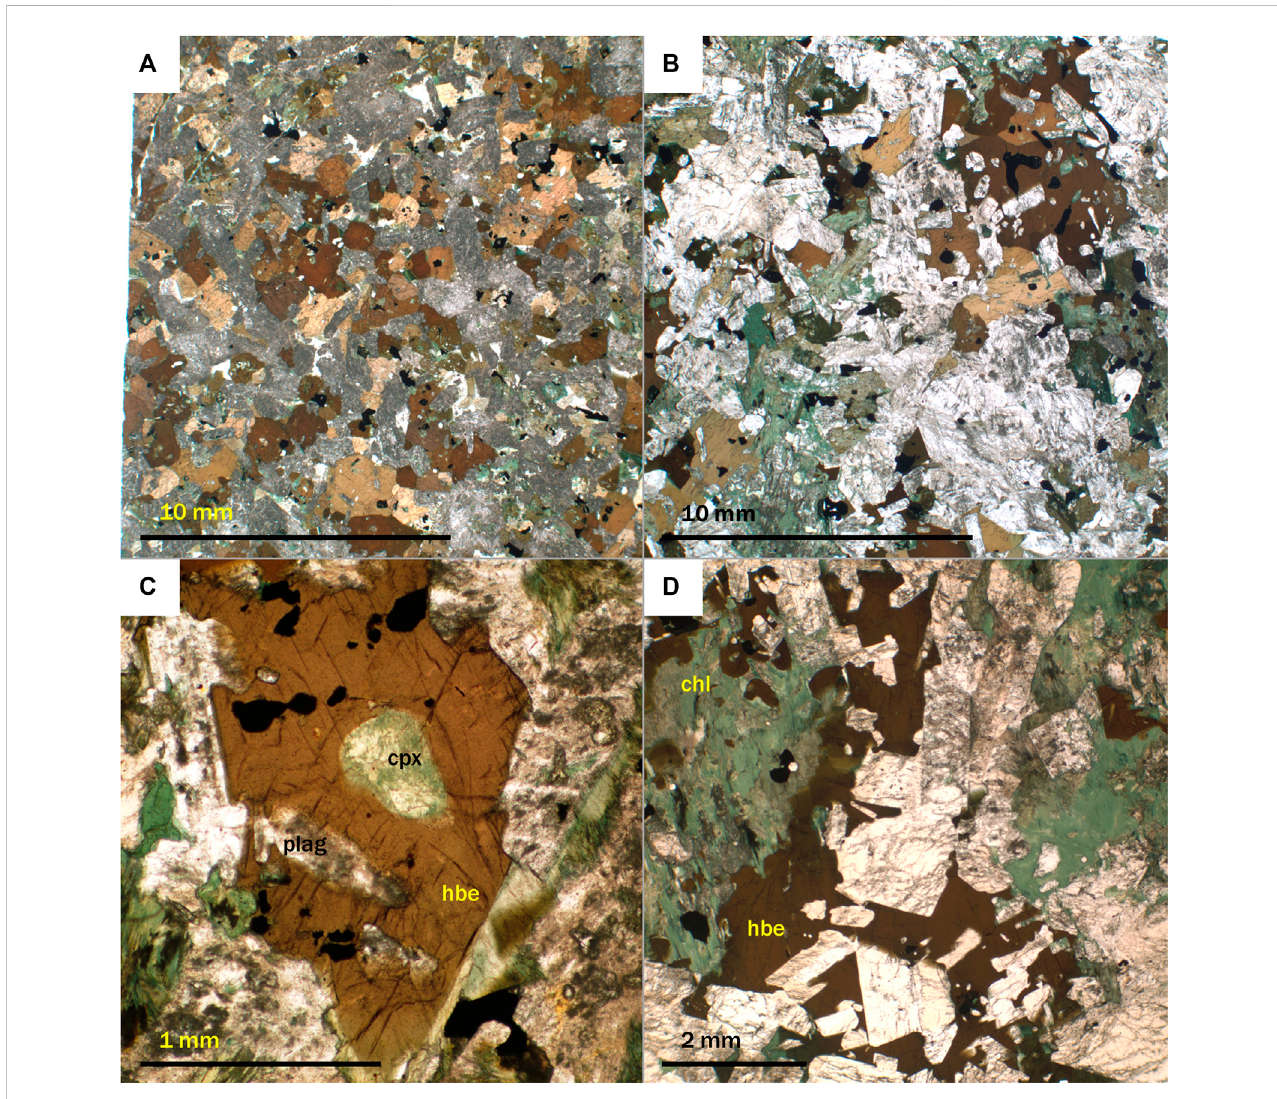
FIGURE 2 Photomicrographs of samples A (A) , B (B) , F (C) and J (D) taken in plane-polarised light. Note the smaller grainsize exhibited by sample A (from the northern end of the NNW-trending ridge) compared to sample B (off-ridge, approximately 600 m west). (A) Even-grained interlocking anhedral hornblende and plagioclase. (B) Patches of hornblende, such as that shown in the top right-hand corner, are common in the medium-coarse-grained samples of the MGD. (C) This fi ne-medium-grained sample (from the ridge, approximately 600 m south of A contains hornblende grains that enclose partially altered clinopyroxene (cpx) and plagioclase (plag). (D) Chlorite (chl) has replaced part of a large hornblende that has grown around multiple plagioclase